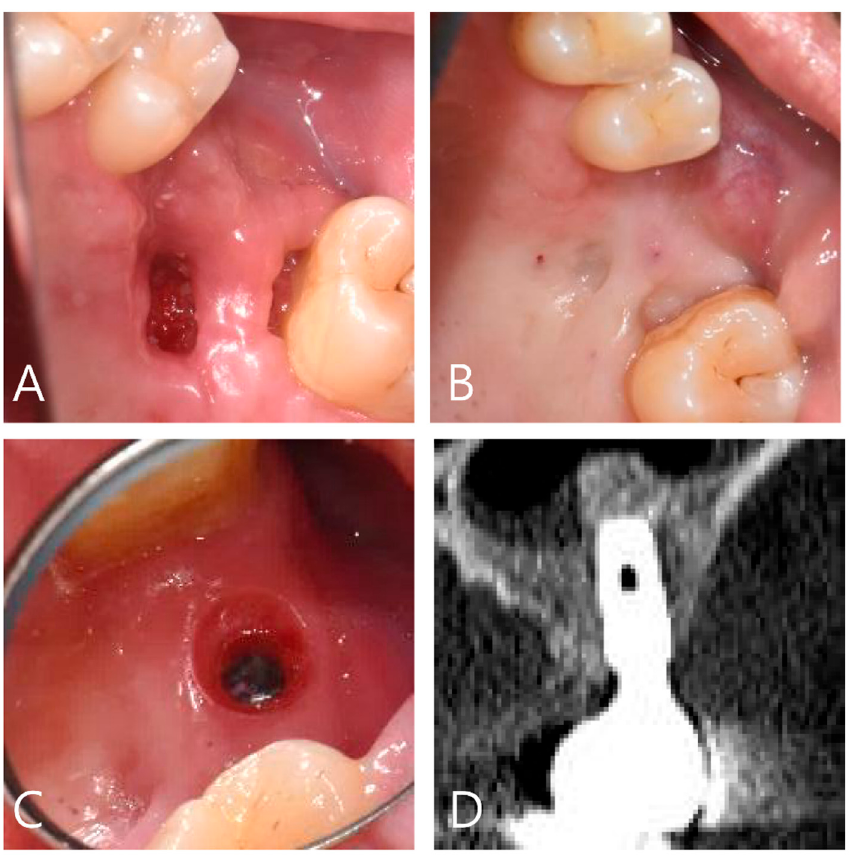
Figure 3. Clinical outcomes of the conservative treatment on case #1. ( A ) After 3 weeks of the conservative treatment, secondary healing was observed in the dehiscence area. ( B ) At 3 months after the surgery, the soft tissue showed a remodeled-healing pattern. ( C ) At 6 months after the graft, the palatal gingiva was well-remodeled. ( D ) The palatal bone showed a cortico-cancellous complex at 12 months after the surgery.